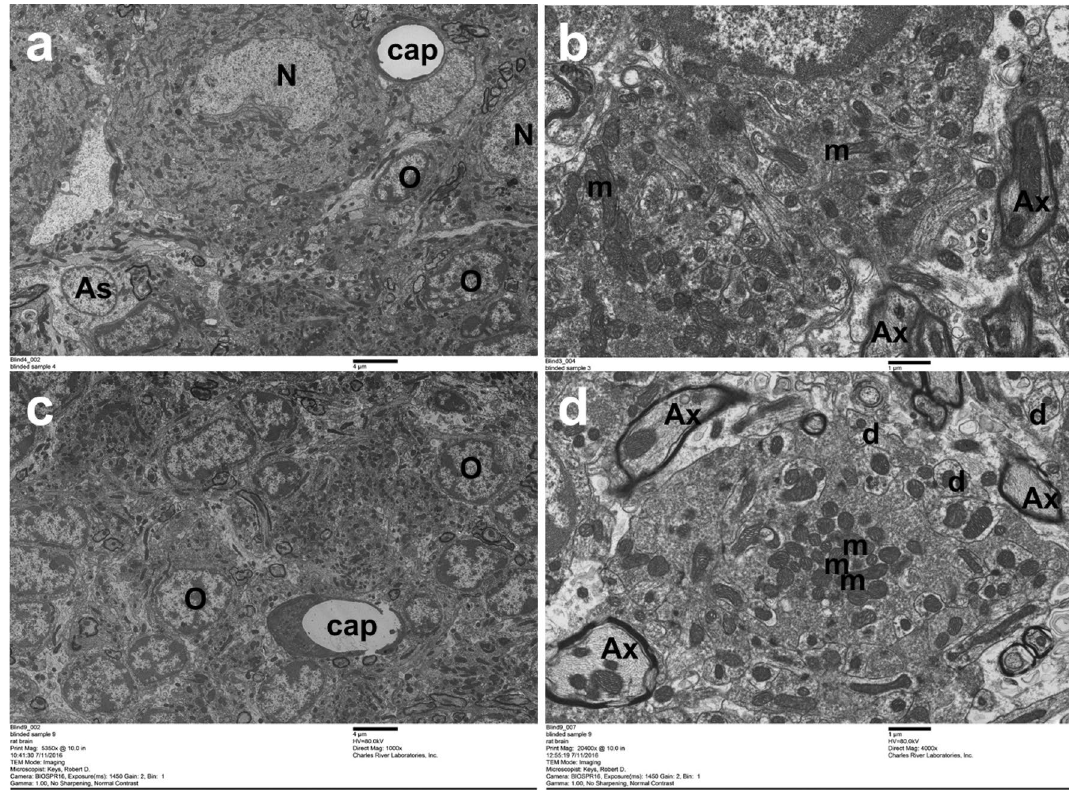
Figure 1. Normal ultrastructure in the deep cerebellar nuclei after repeated doses of gadodiamide. Figures show ultrastructural resolution in the deep cerebellar nuclei after treatment with ( a , b ) gadodiamide or ( c , d ) saline control group. ( a , c ) Low power magnification ×1000, scale bar 4 µm. ( b , d ) High power magnification ×4000, scale bar 1 µm. As astrocyte nucleus, Ax axon, cap capillary, d dendrite, m mitochondria, N neuronal nucleus, O oligodendrocyte nucleus. Images are representative (n = 3 per